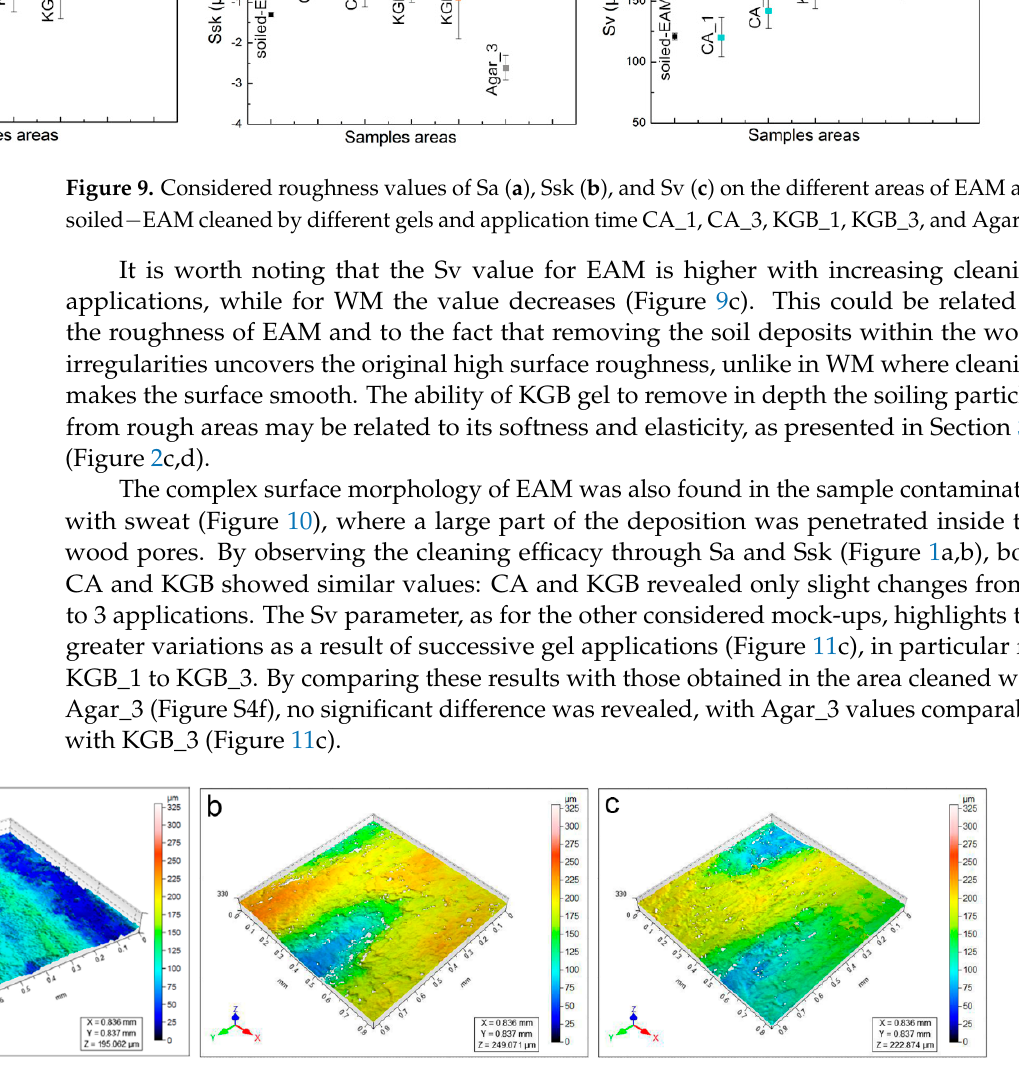
Figure 10. 3D maps of areas on sweat-EAM ( a ) cleaned by KGB_1 ( b ) and KGB_3 ( c ). The colour range represents the different heights of the details present on the sample surface; microns are represented on the relative colour scale.